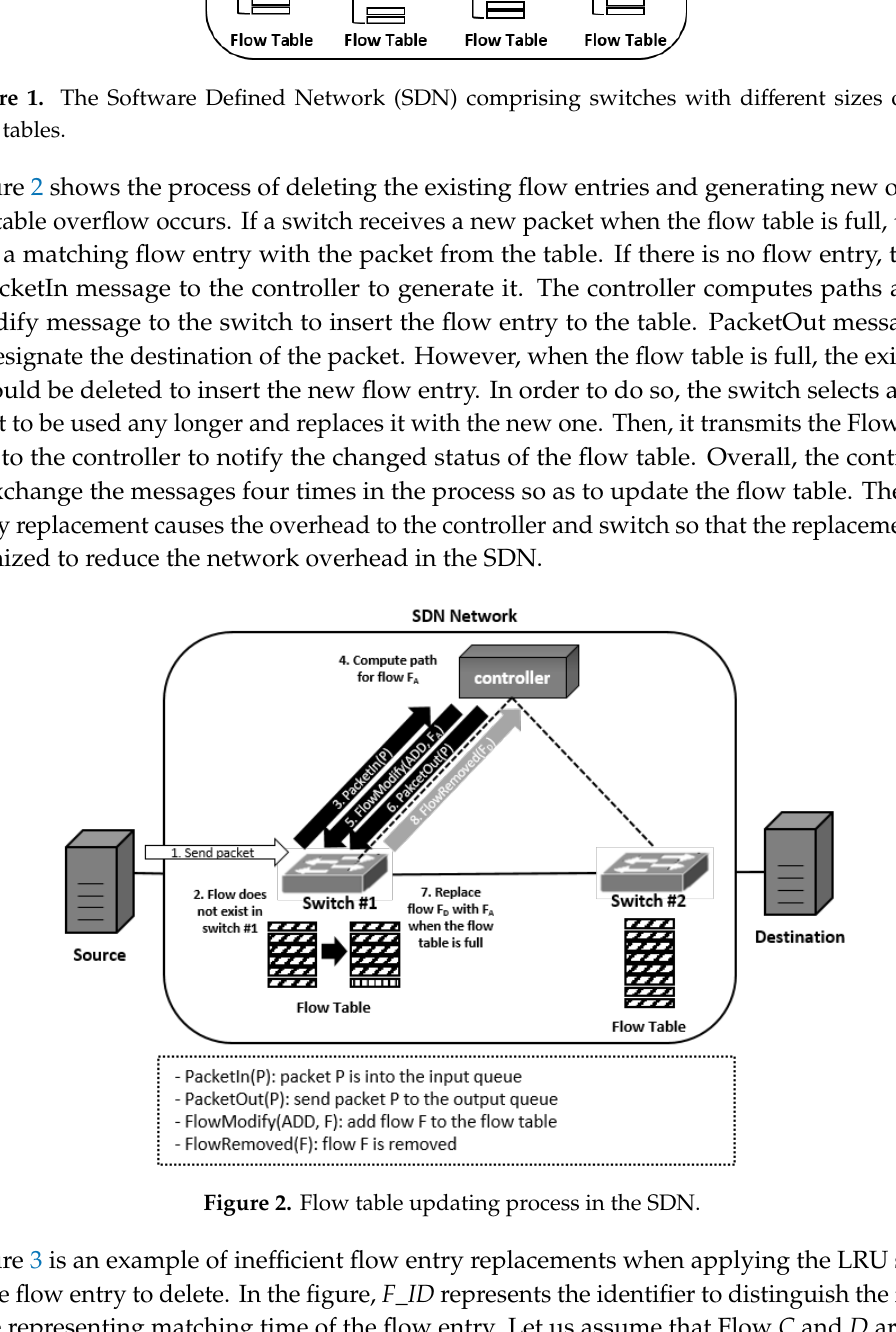
Figure 2. Flow table updating process in the SDN.